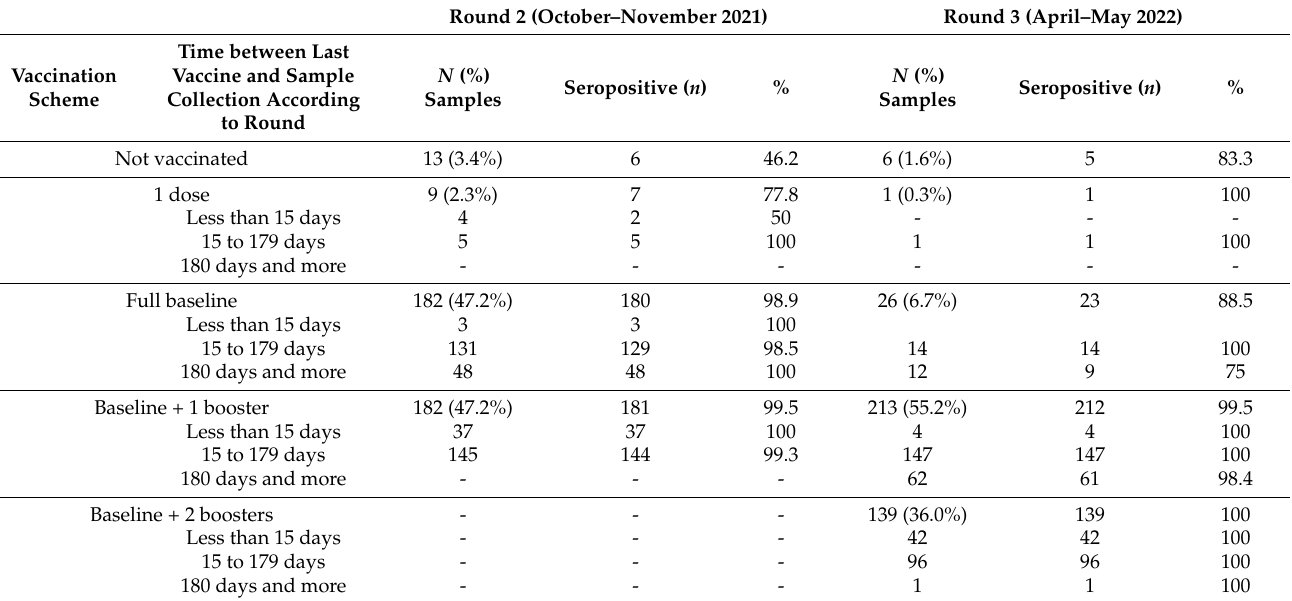
Table 3. Doses of vaccines administered stratified by the time elapsed since last SARS-CoV-2